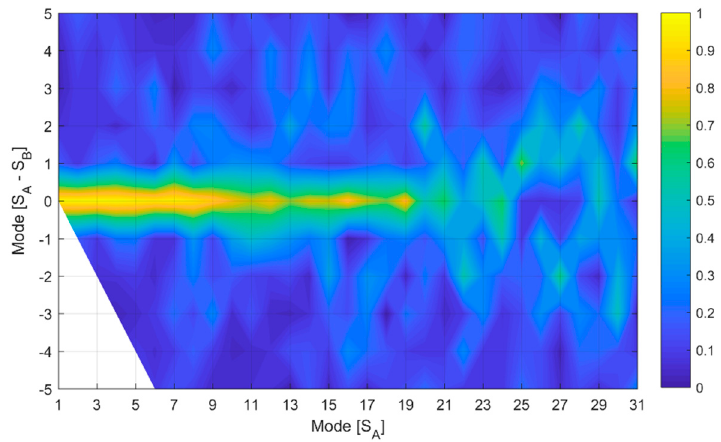
Figure 11. Absolute cross-correlation of POD spatial modes from set A and B. Curtailed at 31 for clarity.